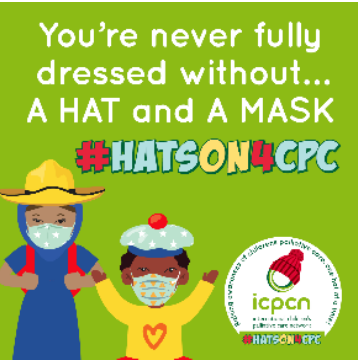
Figure 1. Hats and Masks on for Children’s Palliative Care 2021.